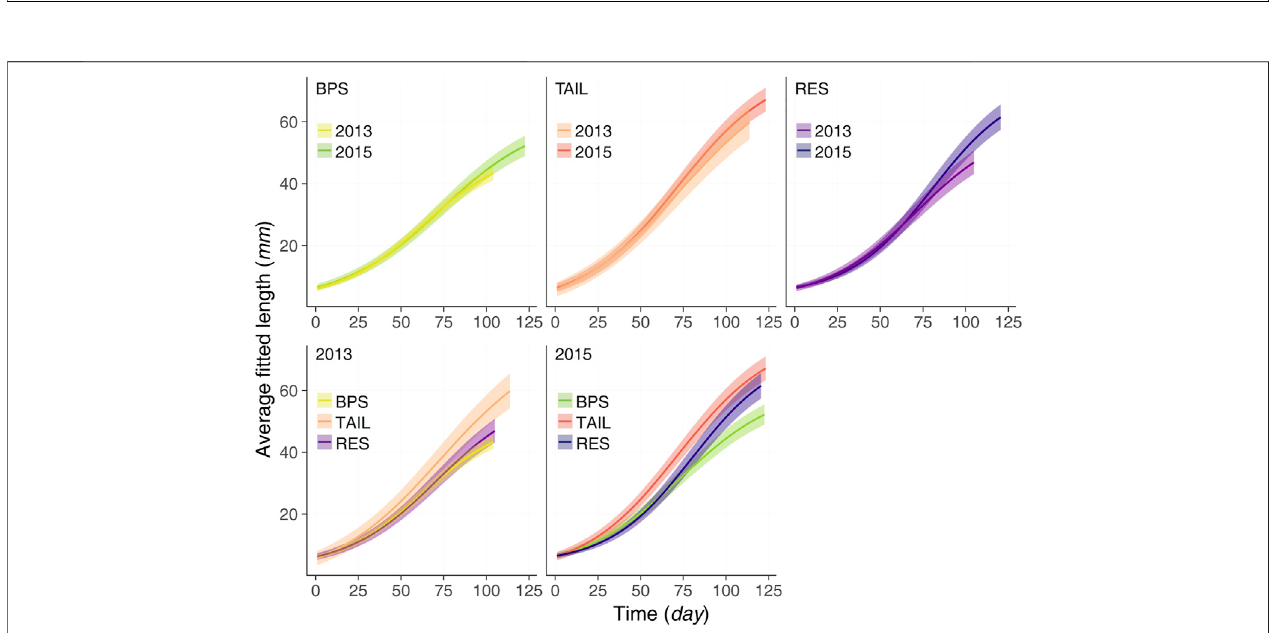
FIGURE 6 | The average growth curves ( lines ) and their associated credible intervals (95%; bands ) for each section and each year during the maximum growth periods observed.